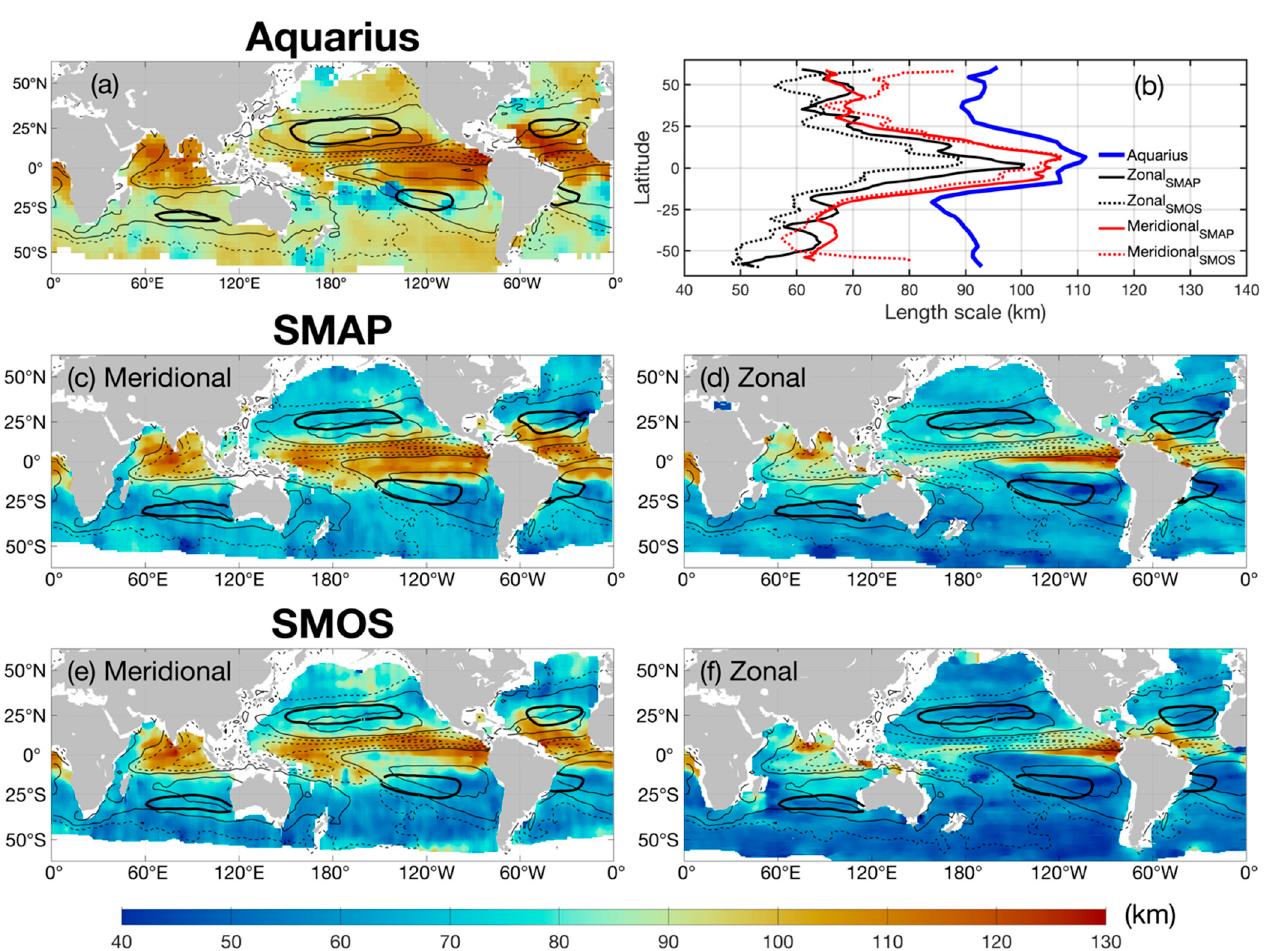
Figure 4. Spatial scales of SSS variability derived from ( a ) Aquarius, ( c , d ) SMAP, and ( e , f ) SMOS satellite missions. For the latter two, spatial scales are calculated in the zonal and meridional directions. Bold contours circle local SSS maxima with isohalines in the North Pacific (35.2 PSU), South Pacific (36.0 PSU), South Indian Ocean (35.6 PSU) and Atlantic Ocean (37 PSU). Thin contours in ( a ) show the climatological mean evaporation minus precipitation ( E − P ) . Solid (dashed) contours indicate positive (negative) E − P ; zero contour is omitted. C. I. is 2.5 mm day − 1 . Zonally averaged length scales are displayed in ( b